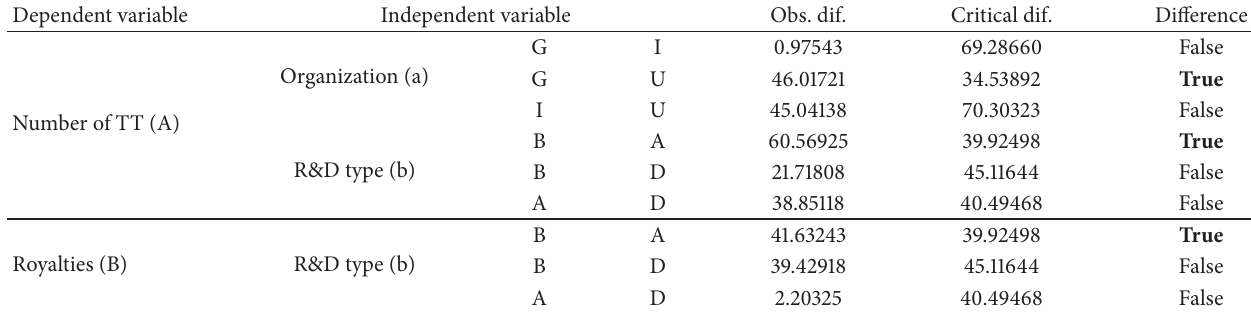
Table 6: Multiple comparison.